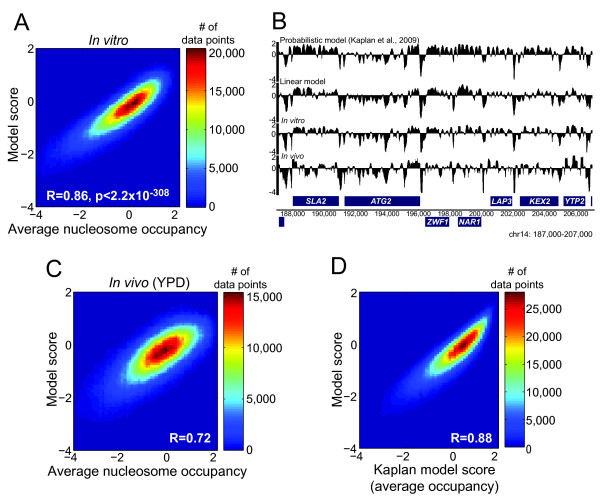
Performance of a 14 feature linear model of intrinsic nucleosome sequence preference. (A) Scatter plot vs. test set (yeast chromosomes 10-16), shown as a heat-map. Axis values are log2 normalized nucleosome occupancy (see Methods). (B) Model scores (probabilistic[8] and linear) and in vivo and in vitro nucleosome occupancy[8] within a 20 kb region of chromosome 14. (C) and (D) Correlation of the 14 feature model score with measured in vivo nucleosome occupancy in yeast (C) and with the Kaplan model across chr10-16 (test set) (D).